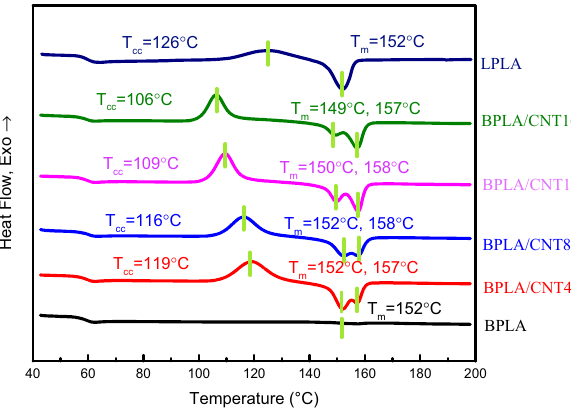
Figure 3: DSC curves of di ff erent PLA